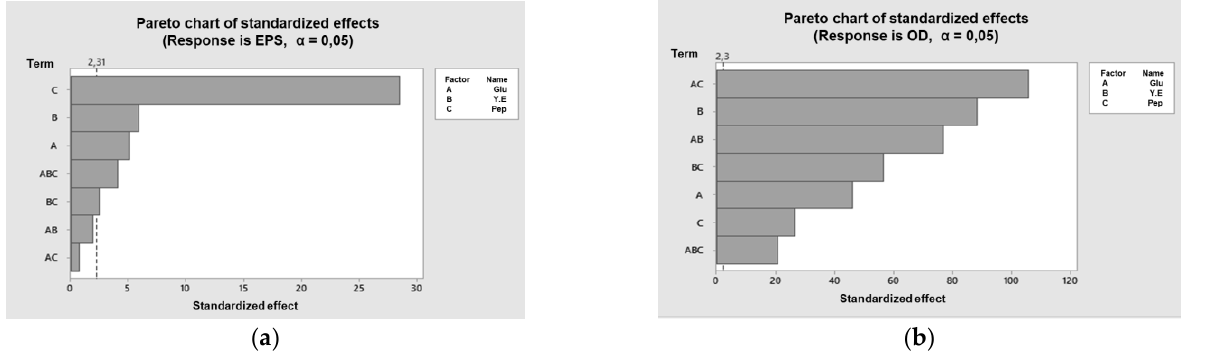
Figure 2. Pareto charts of standardized effects of glucose (A), yeast extract (B) and peptone (C) on EPS production ( a ) and cell growth ( b ) during cultivation of the BU-4 strain in synthetic media.